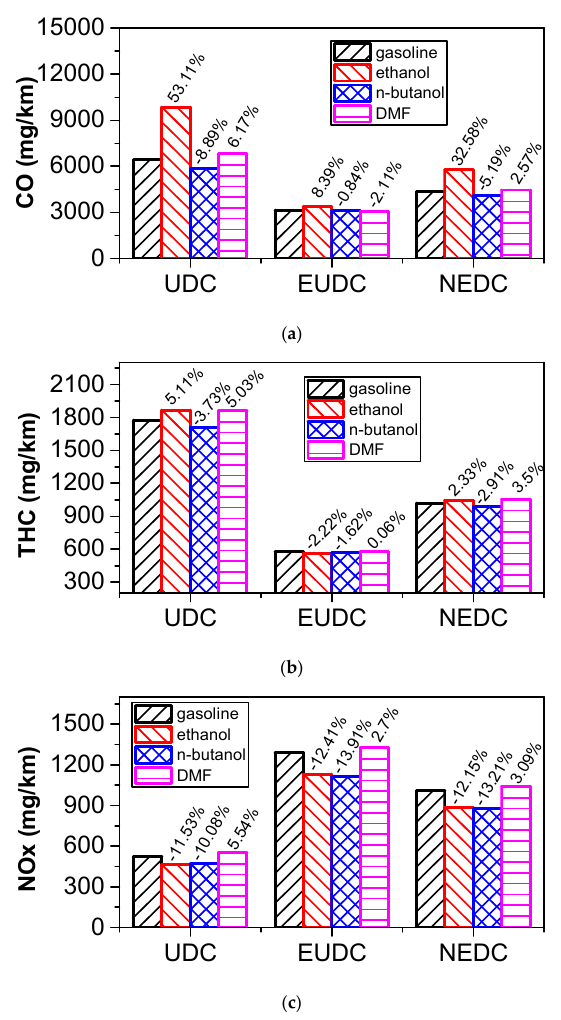
Figure 12. Comparison of CO, THC, and NO X emissions of E20, B20, D20, and gasoline: (a) CO emissions; (b) THC emissions; and (c) NO X emissions.